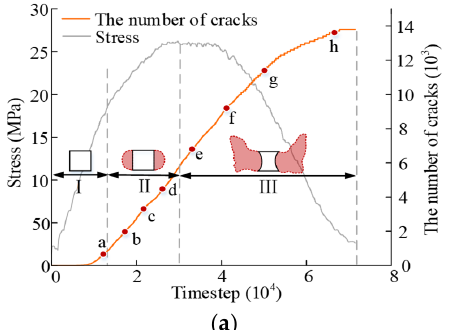
tected in roof-2 and floor-2.